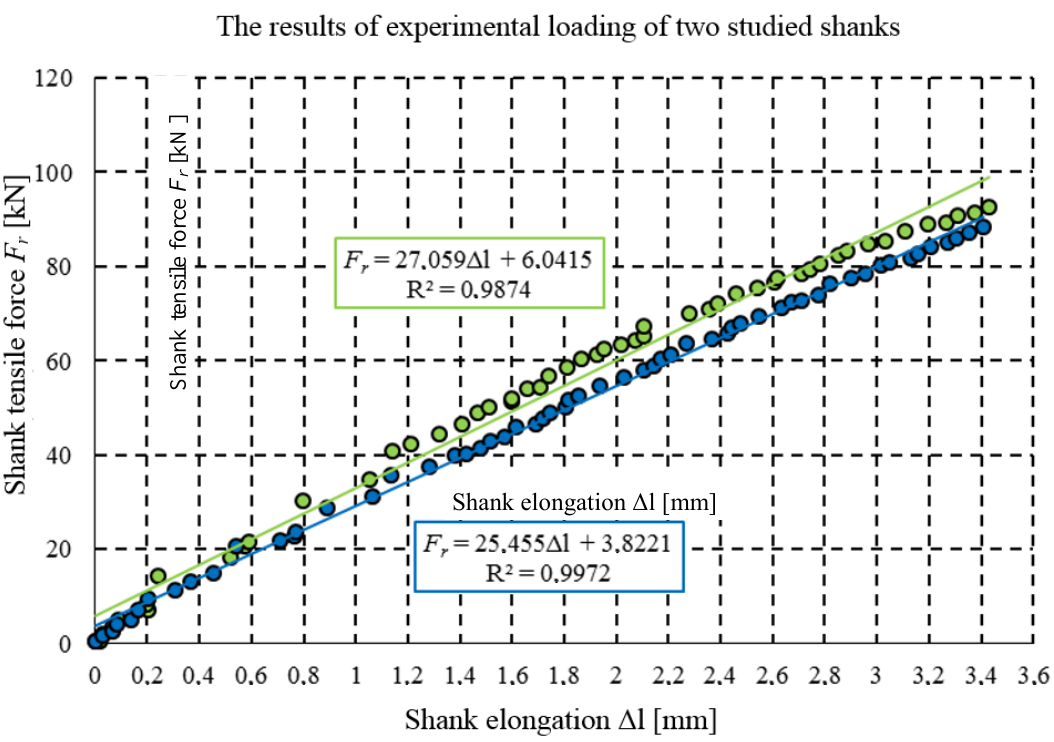
Figure 8. The results of experimental tests involving rupturing threads of two shanks.